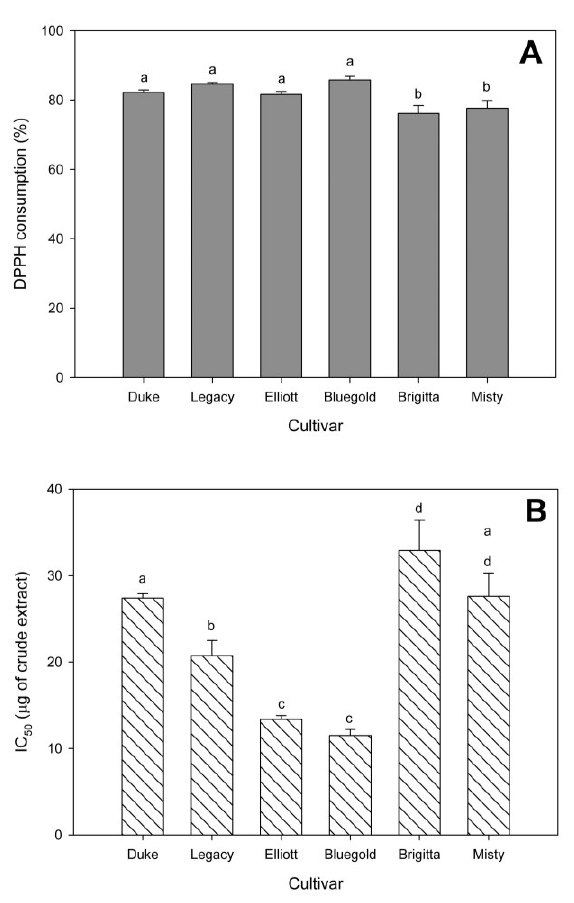
Figure 2. 1,1-diphenyl-2-picrylhydrazin (DPPH•) free radical-scavenging activity of six in vitro highbush blueberry cultivars. ( A ) Total scavenging activity (as a percentage) from 20 μL of mass normalized hydroethanolic extract; ( B ) IC 50 index of DPPH• scavenging activity of hydroethanolic extracts. Each bar corresponds at the mean of nine independent measurements ± standard error; letters represent significant differences ( p < 0.05).